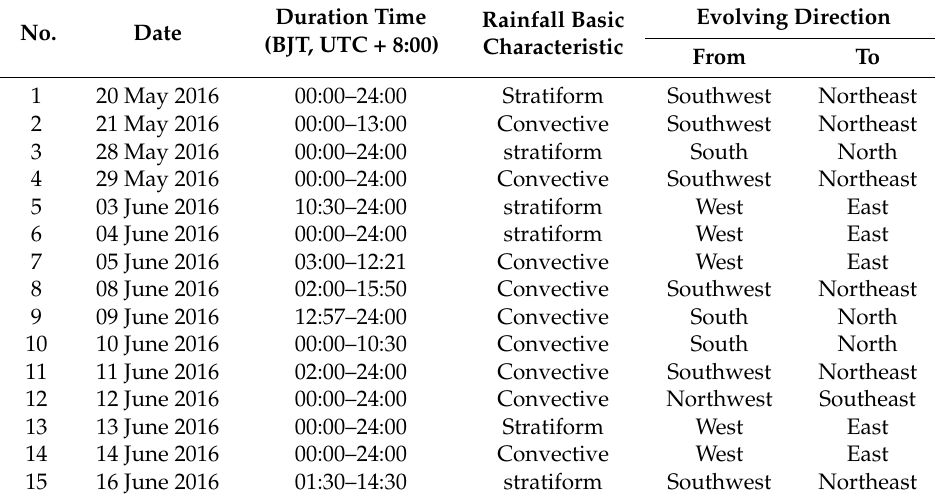
Table 2. Rainfall events list observed by XPRAD during intensive observation period (IOP) in pre-summer